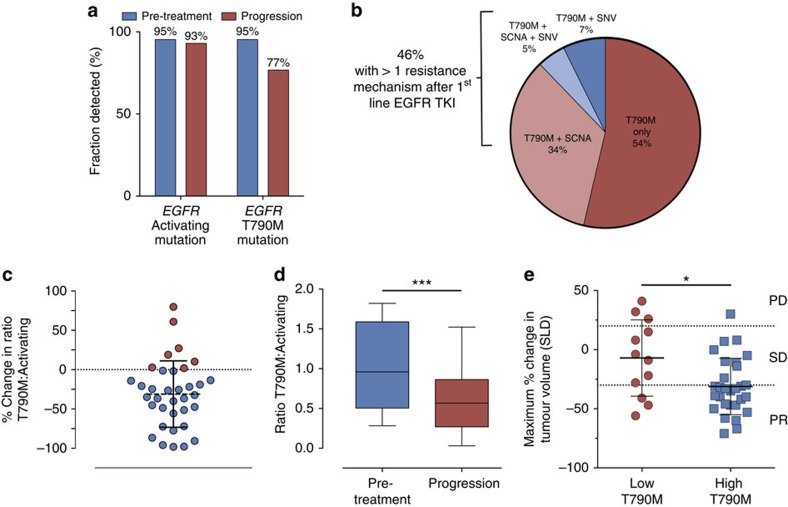
Heterogeneity of resistance mechanisms and EGFR mutation dynamics in response to EGFR TKIs.(a) Detection of EGFR-activating and T790M resistance mutations in pre-treatment and progression plasma samples from rociletinib-treated patients (n=43) using CAPP-Seq. (b) Summary of putative resistance mechanisms to first- and second-generation EGFR TKIs present in the pre-rociletinib plasma sample of patients with T790M mutations (n=41). (c) The percent change in the relative ratio of T790M to activating mutation alleles in progression plasma samples compared with pre-treatment samples from rociletinib-treated patients. Patients in whom the ratio decreased (n=28) are coloured blue and patients in whom the ratio increased (n=7) are coloured red. Only patients in whom both activating and T790M mutations were detectable pre-treatment, and activating mutations were detectable at progression are included. (d) Box and Whisker plots depicting the relative ratio of T790M and activating mutation alleles in pre-treatment and progression plasma samples from rociletinib-treated patients. The solid box represents the interquartile range of values and whiskers represent the 10th and 90th percentile values. All patients depicted in c are included. (n=35, ***P<0.0005, Wilcoxon signed-rank test). (e) Comparison of the ratio of T790M to EGFR-activating mutation in pre-treatment plasma samples and the best RECIST response to treatment with rociletinib. Patients with low baseline T790M (n=12, ratio ≤0.5) have significantly less reduction in tumour volume than patients with high baseline T790M (n=29, ratio > 0.5; * P<0.05, Wilcoxon rank-sum test). Only patients in whom both activating and T790M mutations were detectable pre-treatment are included.